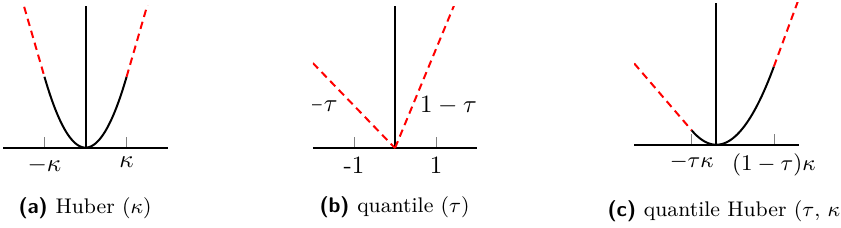
Figure 1 Huber and quantile families parametrized by κ and τ , with the quantile Huber parameterized by both. Linear pieces are shown using red dash; curvilinear pieces are shown using black